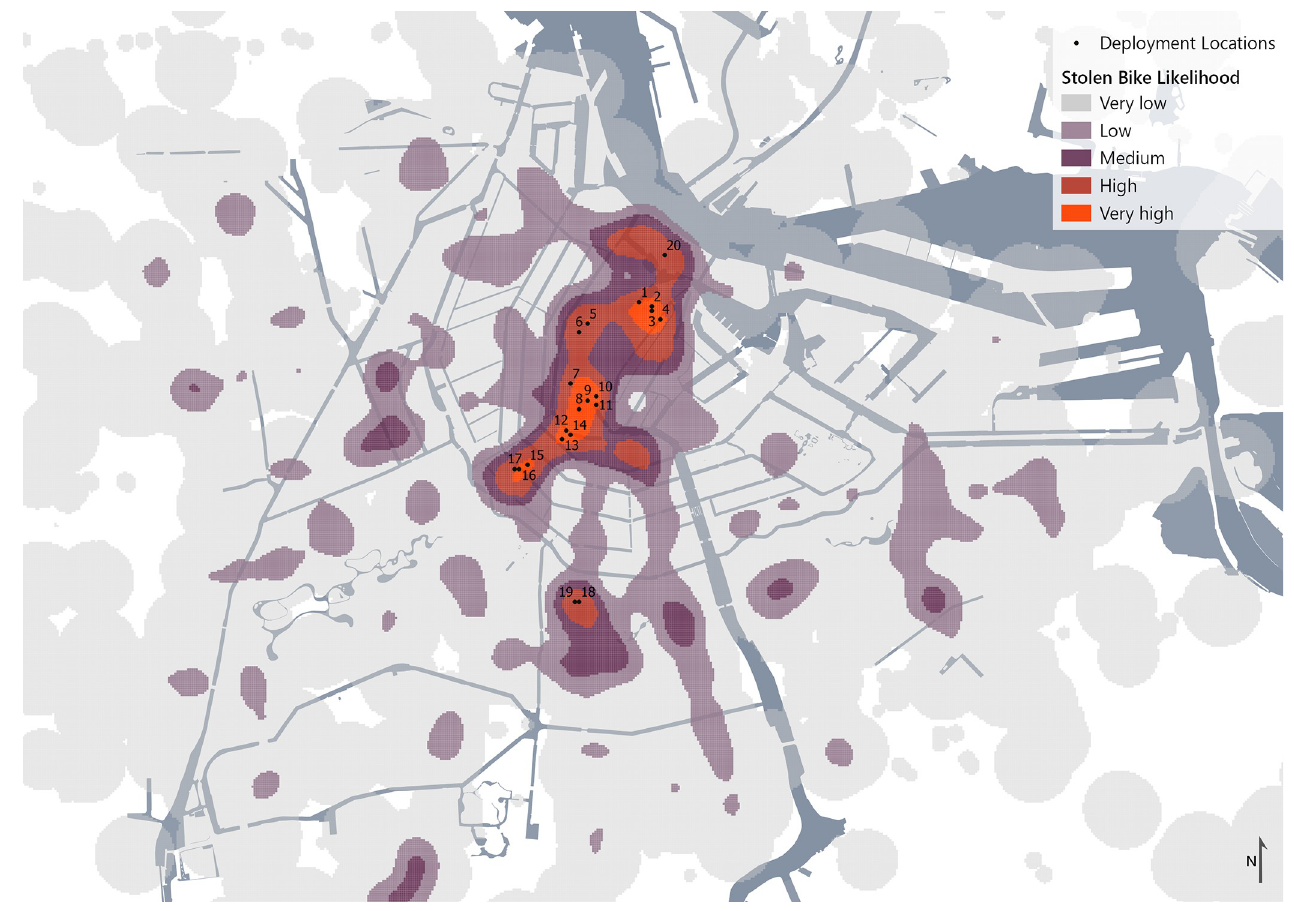
Fig 8. Deployment locations and likelihood indicator, base map data from